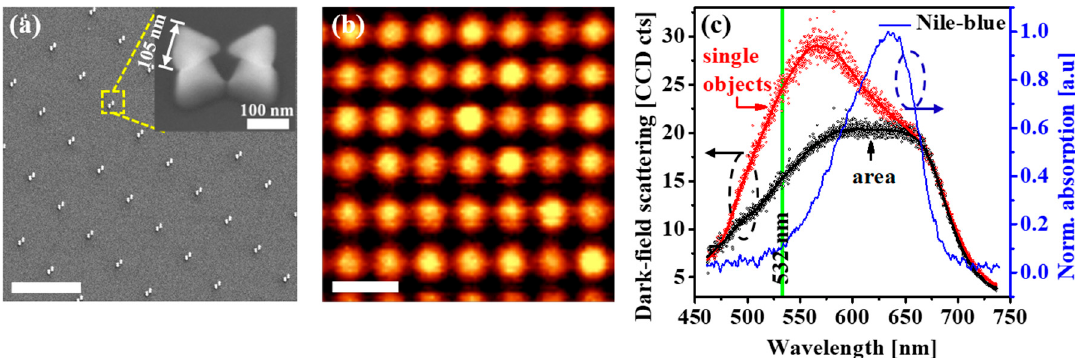
Figure 2. Spectral mapping of the free-standing Al bowtie antennas. ( a ) A scanning electron microscope (SEM) of the Al antenna arrays, observed at 30° oblique angle and the inset of one typical bowtie antenna. The antennas are spatially distributed with periodicity of 1400 nm, spacing of 1120 nm, 105 nm length and 20 nm gap. ( b ) The spectral mapping integrated over the resonance of the antennas, ranging from 500 nm to 700 nm. The circular “hot-spots” are spatially distributed following the SEM image, as shown in ( a ). The scale bar is 2 µm for both ( a ) and ( b ). ( c ) Spectral response of the single antenna (red), antenna array (black) and absorption spectrum of Nile-blue (blue), details in the text.